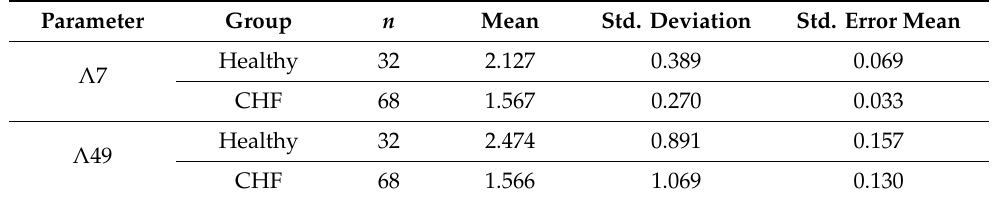
Table 6. Group statistics for the H subjects and CHF patients (ECG method).